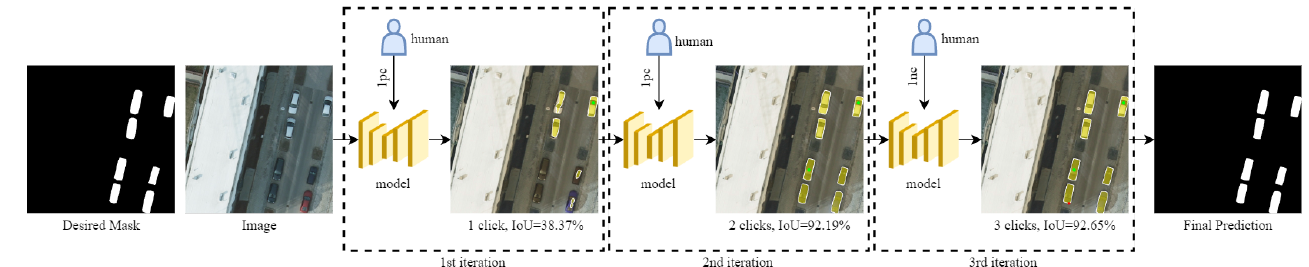
Figure 1. An overview of a click-based interactive segmentation system. “pc” and “nc” stand for positive (green points in RS images) and negative (red points in RS images) clicks placed by a human for foreground and background selection, respectively. Users can obtain the desired high-quality masks with just a few simple